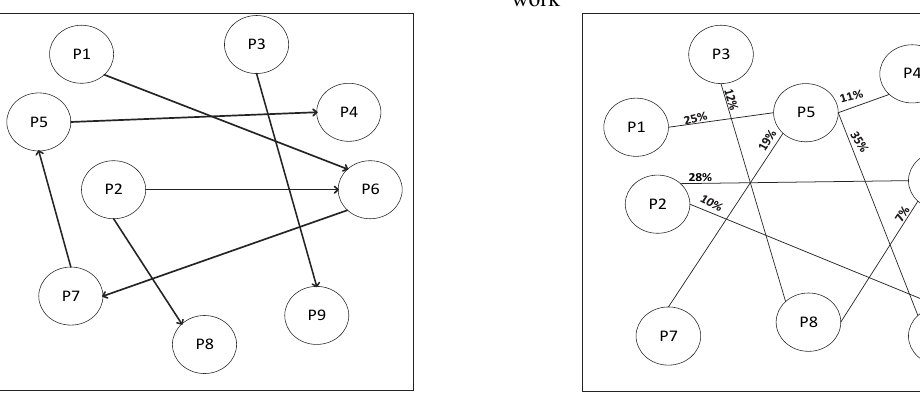
Fig. 8. Technical interdependencies network Fig. 9. Market interdependencies network